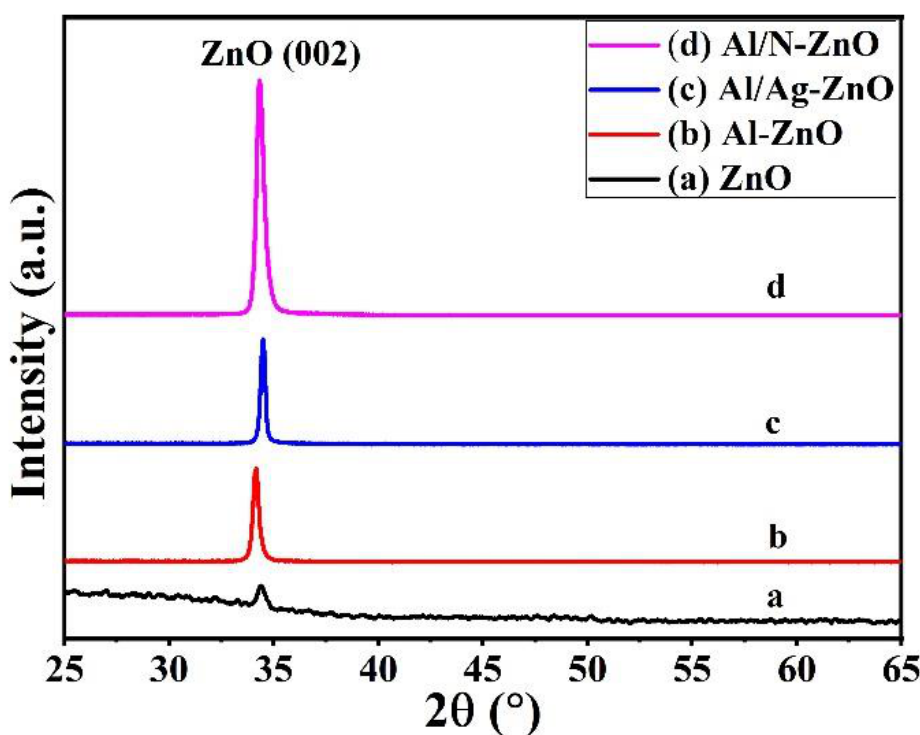
Figure 2. XRD patterns of ZnO (a), metal single doping ZnO (Al-ZnO) (b), metal/metal co-doping ZnO (Al/Ag-ZnO) (c), and metal/non-metal co-doping ZnO (Al/N-ZnO) (d).